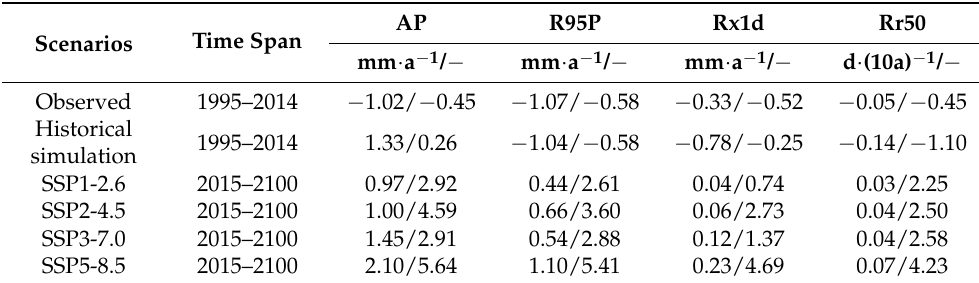
Table 4. Tendency rate and M-K statistics of extreme rainfall index under SSPs scenarios in the Huai River